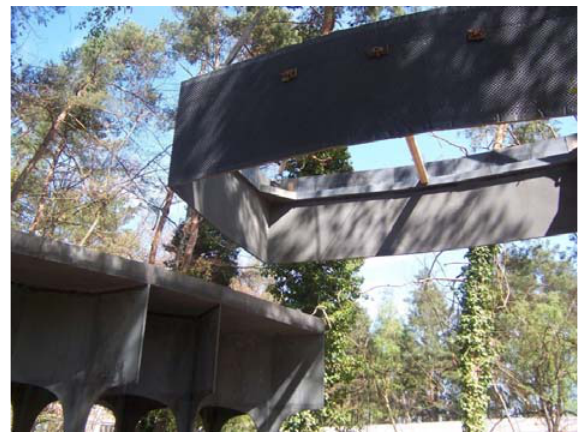
Figure 4. FIFA World Cup Pavilion, City of Kaiserslautern, Germany – mounting the attic. The largest application of SAP as internal curing agent thus far was carried out in Chinese railway construction [19].